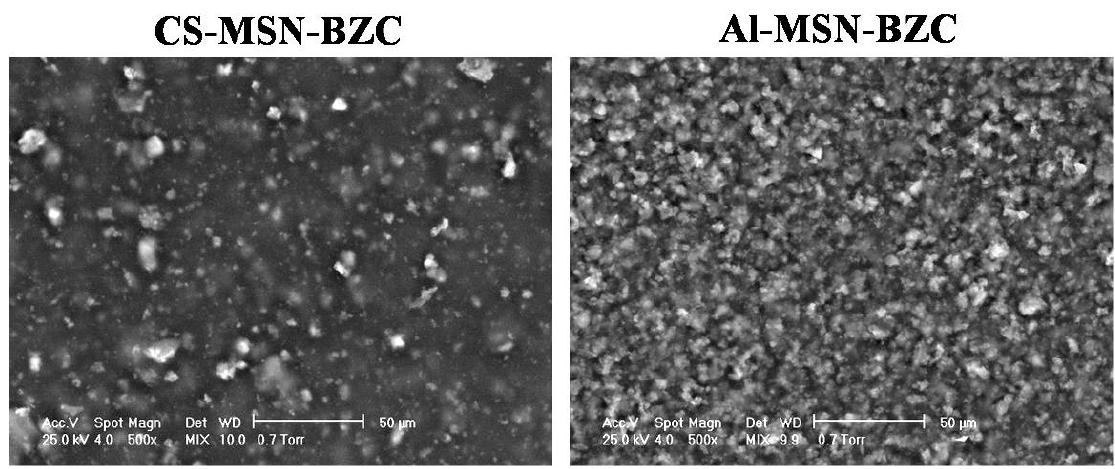
Figure 10. Scanning electron microscope (SEM) images recorded on the CS-MSN-BZC and AL-MSN BZC films.